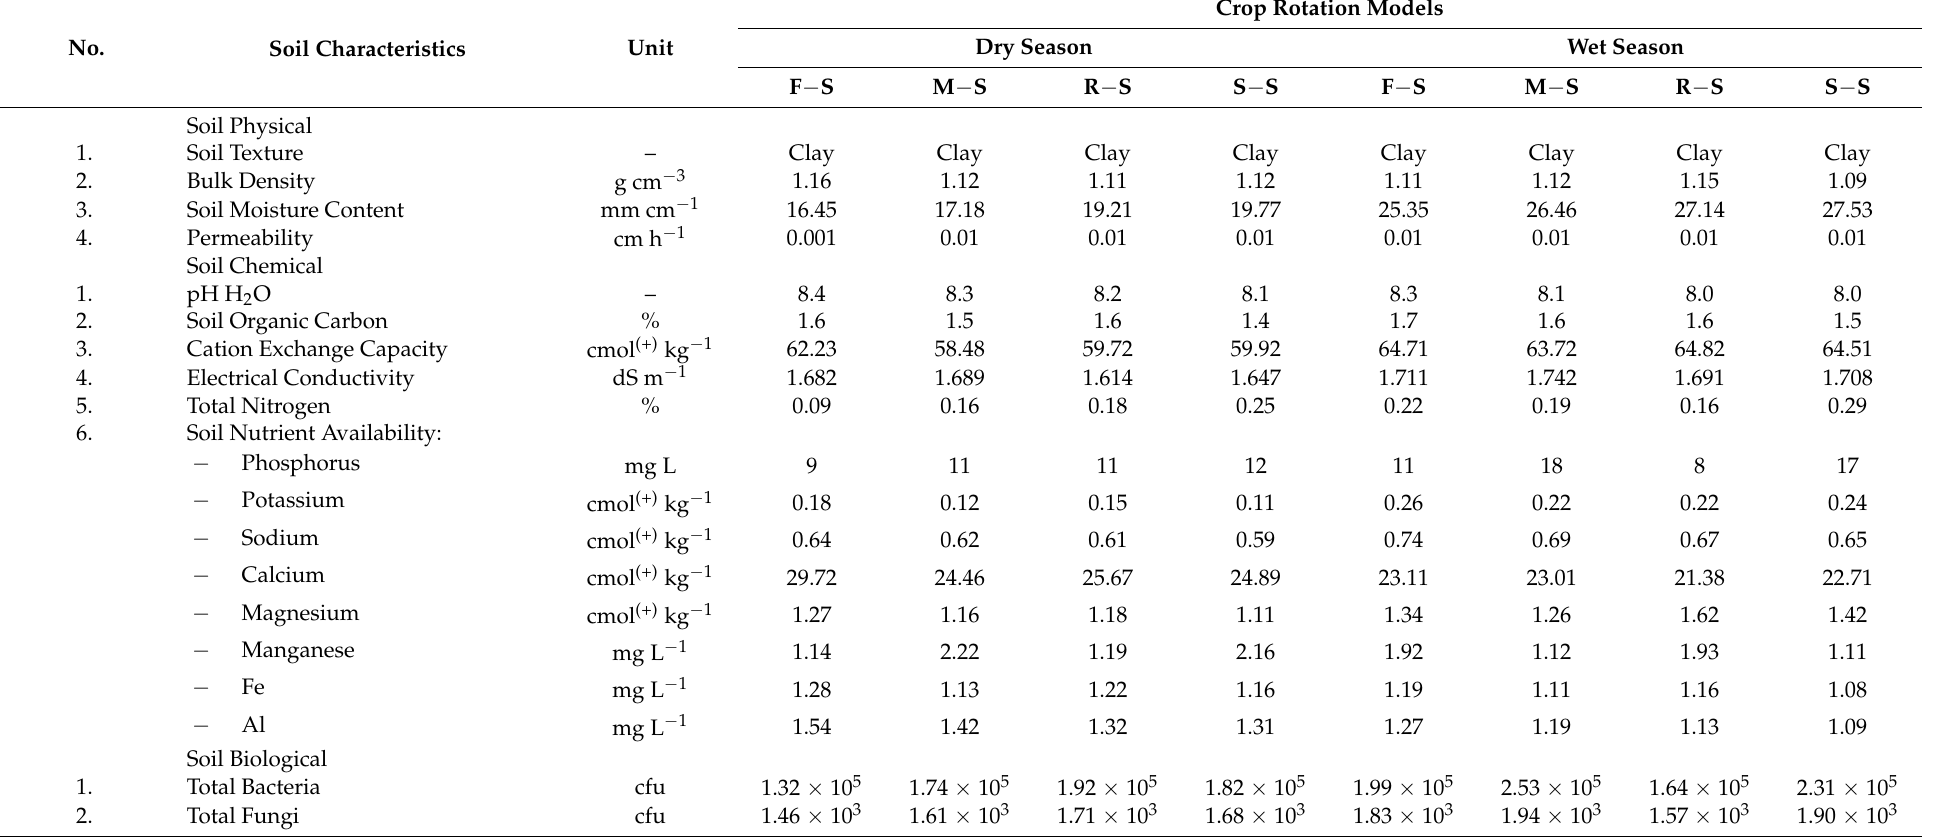
Table 3. Soil characteristics (physical, chemical, and biological) in study